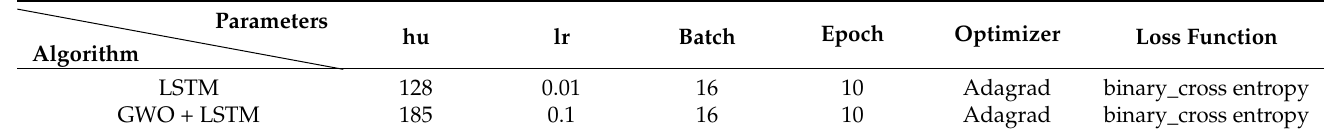
Table 2. Comparison of (hu, lr) before and after GWO optimized LSTM.